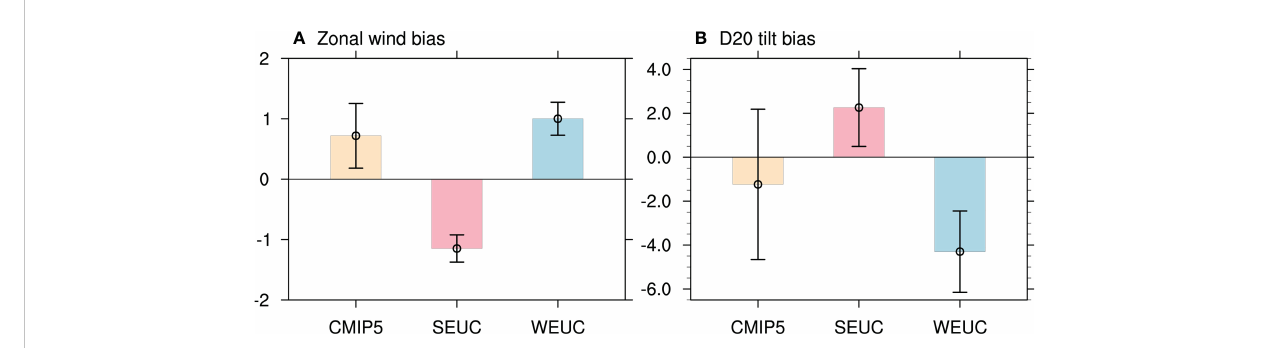
FIGURE 9 Histograms of the (A) JFM mean 925-hPa zonal wind biases (units: m/s) averaged for 2° S – 2° N, 50 – 80° E and (B) FMA mean D20 tilt (2° S – 2° N, 50 – 70° E minus 70 – 90° E) biases in the MME of the CMIP5 models (yellow bars), the SEUC group (red bars), and the WEUC group (blue bars). The error bars indicate the standard deviation spread among the models.